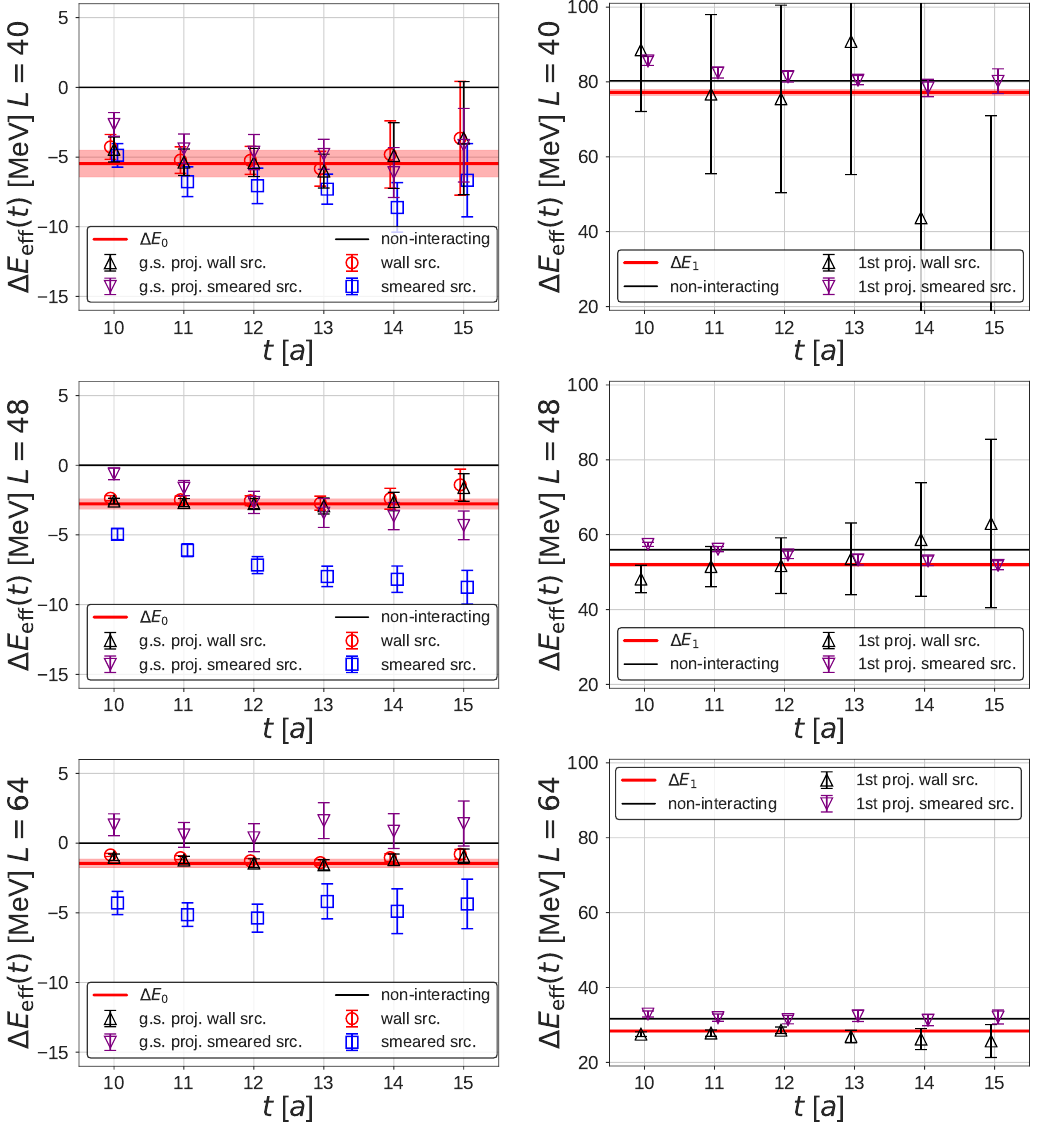
Figure 17 . Same as (cid:12)gure 12 on L = 40 (top), 48 (middle) and 64 (bottom).